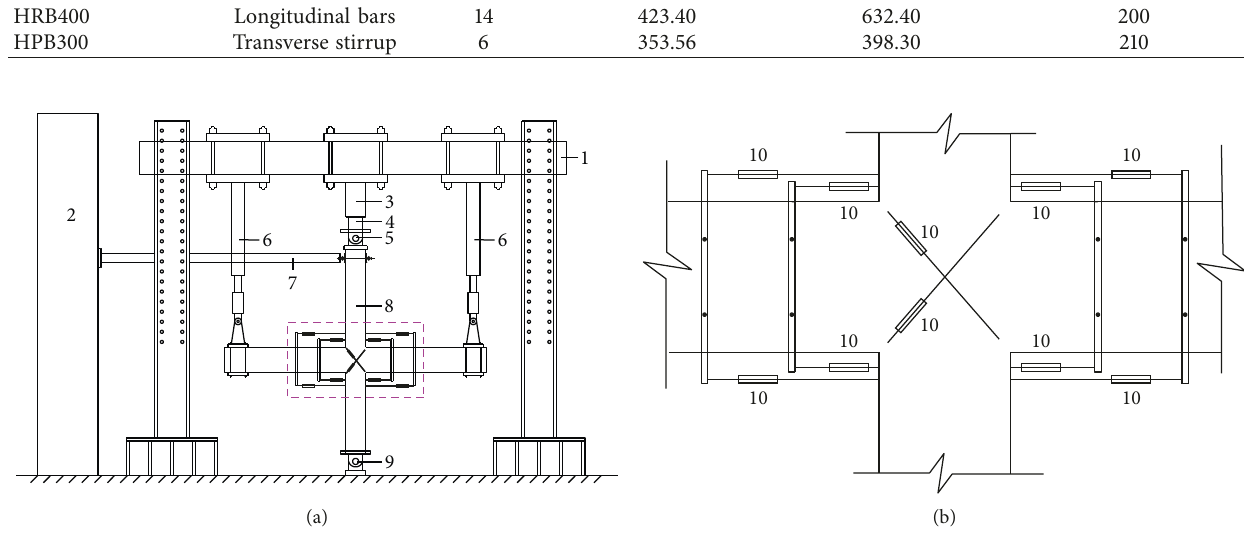
Figure 3: Loading device of the test. (a) Schematic diagram of load test. (b) Displacement sensor arrangement. (1) Rigid frame; (2) reacting- force wall; (3) hydraulic jack; (4) load sensor; (5) hinge; (6) MTS actuators; (7) spreader beam; (8) specimen; (9) hinge base; (10) dis- placement sensor.